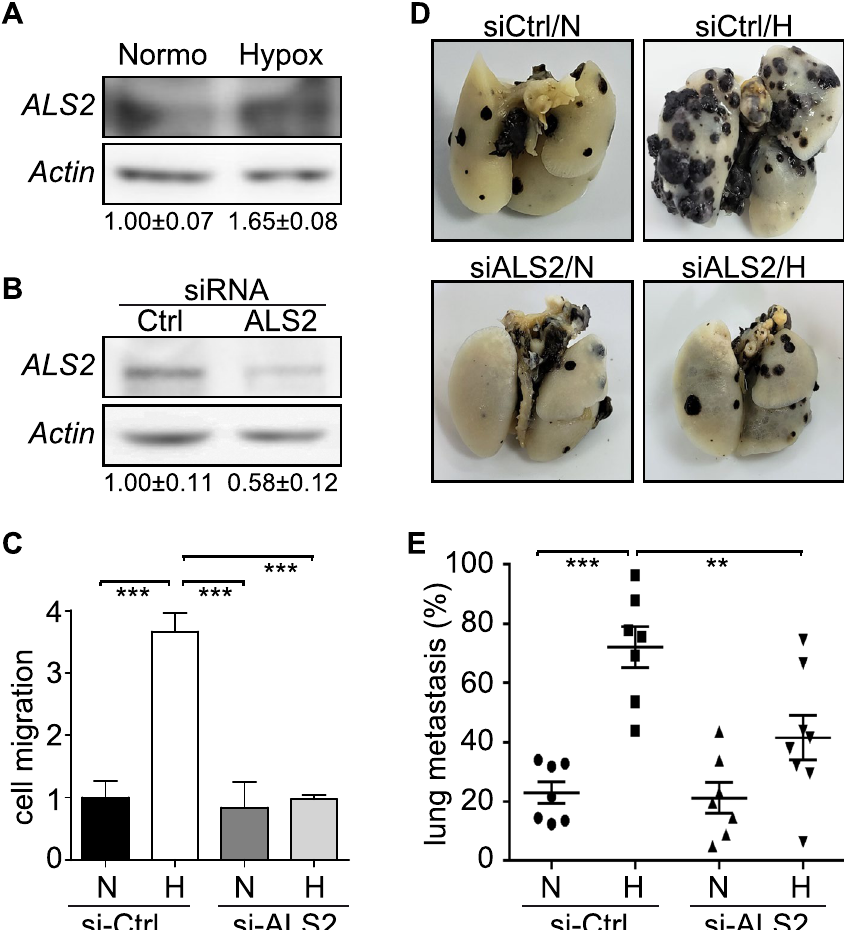
Figure 4. ALS2 participates in hypoxia-induced melanoma cell migration in vitro and lung colonization in vivo. ( A ) B16-F10 murine melanoma cells were incubated in normoxia or hypoxia for 24 h and whole cell lysates were prepared for Western blot analysis of ALS2 and actin. Representative Western blot images are shown, and relative levels of ALS2 were quantified by scanning densitometry and normalized to actin. Numbers below each panel indicate the average from 3 independent experiments (mean ± SEM). ( B ) B16-F10 cells were transfected with either control siRNA or a mix of siRNA sequences targeting murine ALS2 (for full description, see materials and methods) and whole cell lysates were prepared at 48 h post-transfection. Representative Western blot images are shown for ALS2 and Actin, and numerical data below panels represent the average